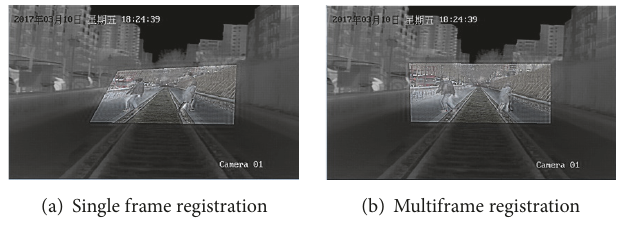
Figure 10: Fusion result of single and multiframe